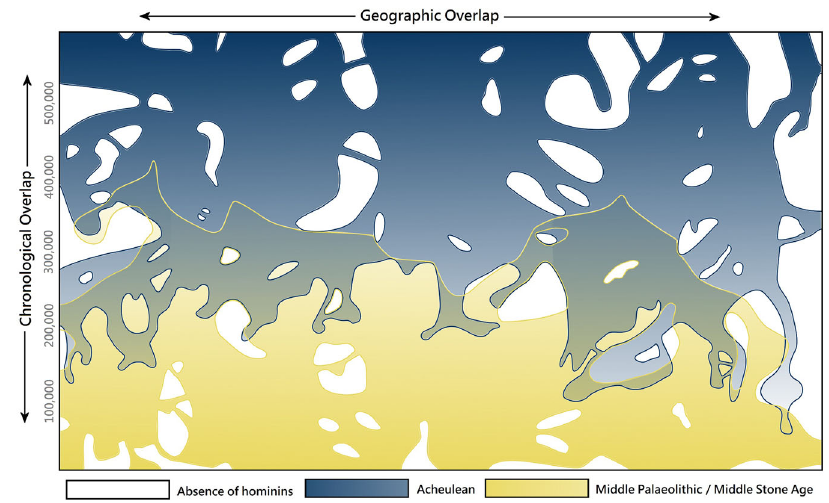
Fig. 5 Hypothetical temporal and geographic overlap between the Acheulean (blue) and MP/MSA (yellow). Distributions of each technology are represented from ~550 to ~50 Kya (top to bottom), respectively. Although hypothetical, the population dynamics outlined here demonstrate how localised extinctions, colonisation waves and admixture likely in fl uenced the distribution of the Acheulean. It is still unknown whether the MP/MSA originated in one location before spreading to alternative populations, or it independently originated in multiple regions. Here, we have illustrated the latter